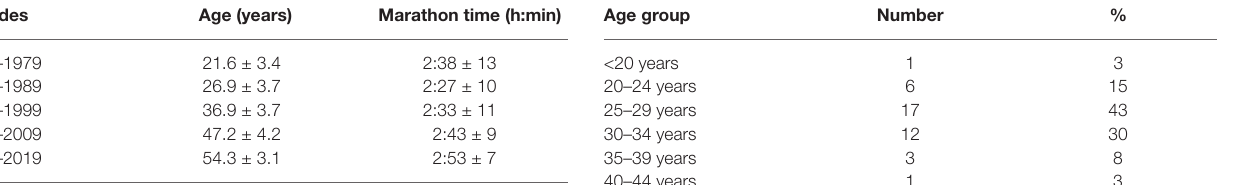
TABLE 1 | Mean age and marathon time performance of the 5DS3 runners ( n = 40) during the five consecutive calendar decades. Decades Age (years)